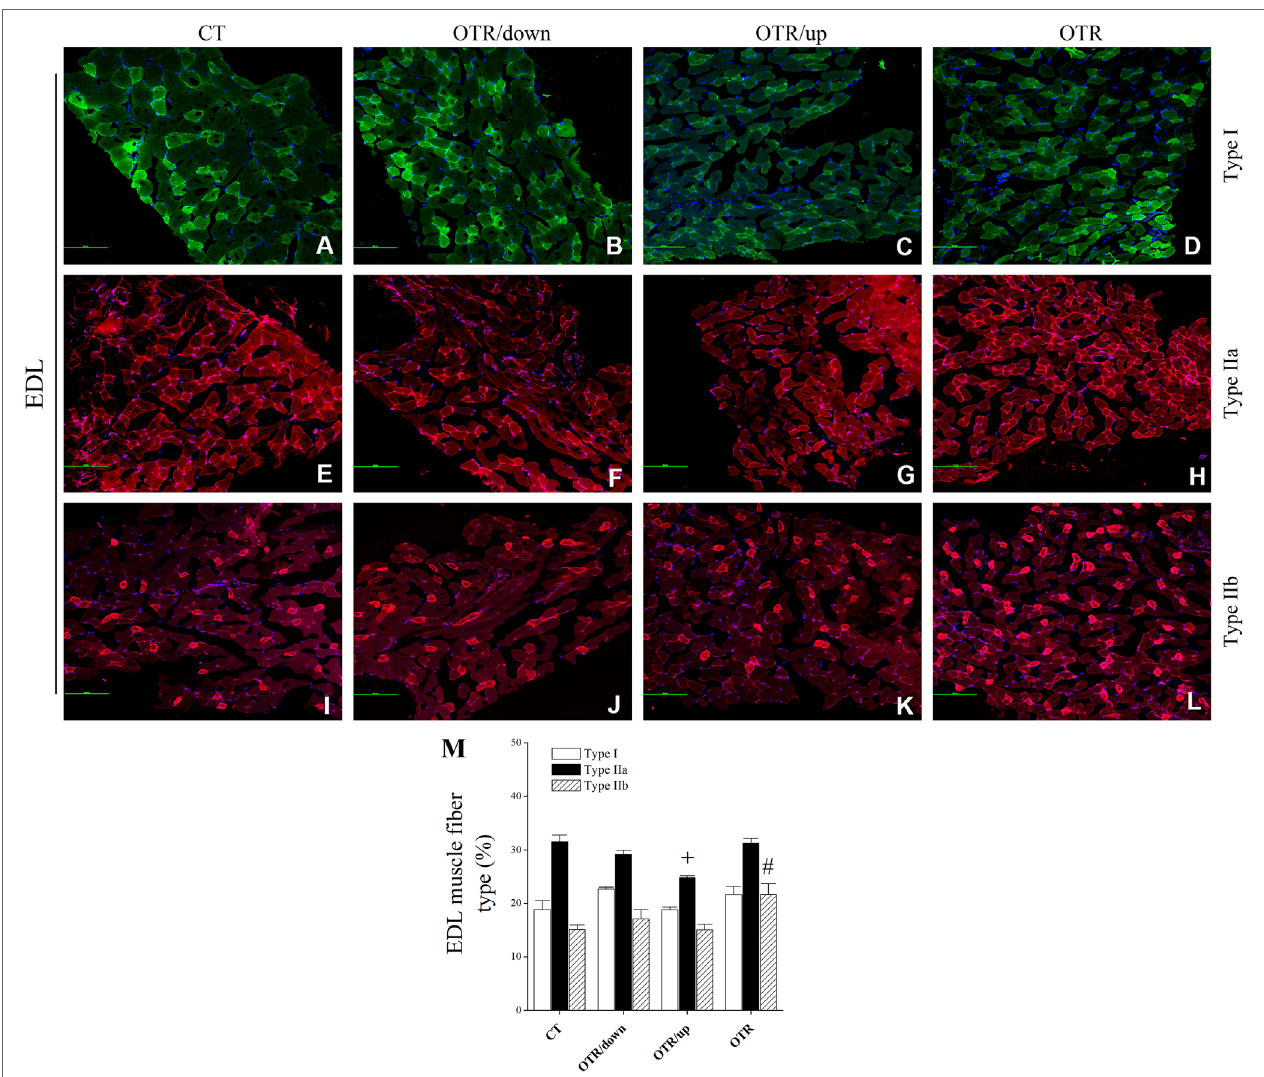
FigUre 4 | Immunofluorescence images of extensor digitorum longus (EDL) muscle fiber type composition from control (CT) [ (a) type I, (e) type IIa, and (i) type IIb], downhill running-based overtraining (OTR/down) [ (B) type I, (F) type IIa, and (J) type IIb], OTR/up [ (c) type I, (g) type IIa, and (K) type IIb], and OTR [ (D) type I, (h) type IIa, and (l) type IIb]. Percentage of type I, type IIa, and type IIb (M) fibers in EDL muscle. Data correspond to n = 4 mice. CT: sedentary mice. OTR/down: overtrained by downhill running. OTR/up: overtrained by uphill running. OTR: overtrained by running without inclination. + P < 0.05 vs. CT, OTR/down, and OTR; # P < 0.05 vs. CT and